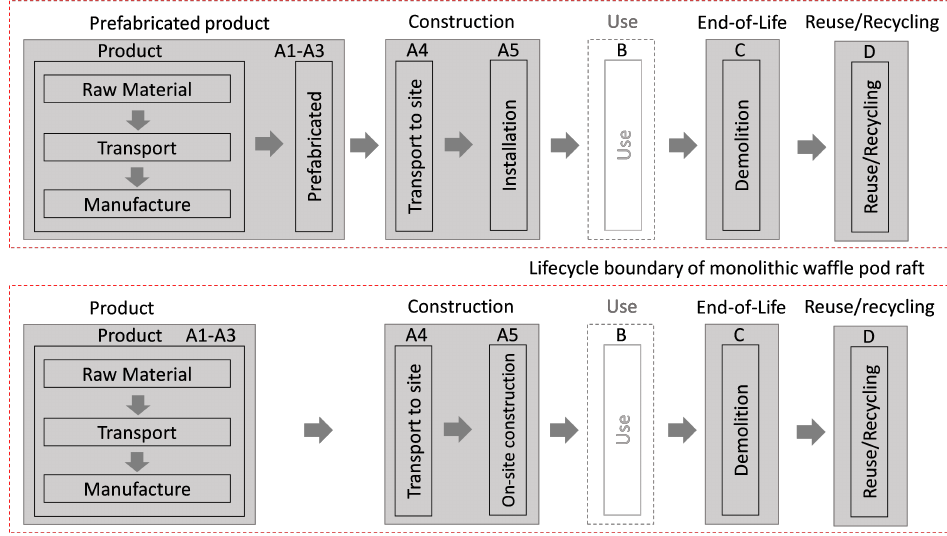
Figure 5. Life cycle boundaries of two footing